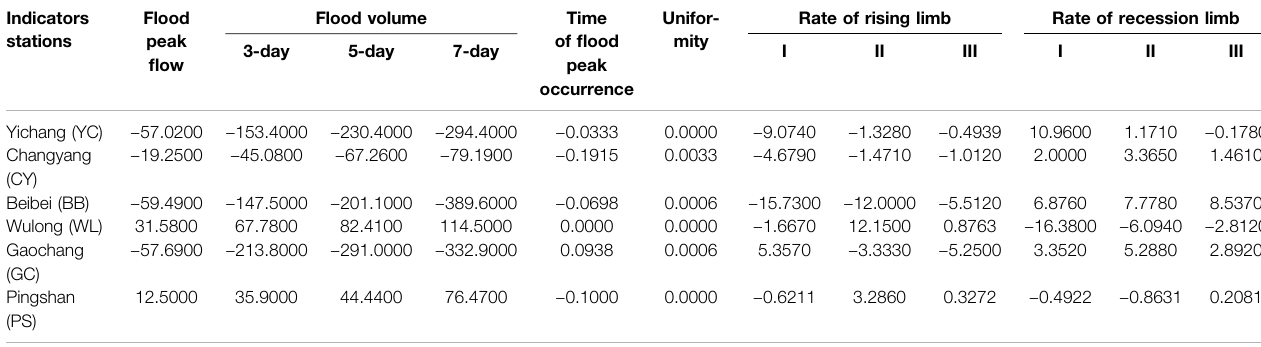
TABLE 4 | The Theil – Sen slope estimator of evaluation indicators at the six stations in the UYR. Indicators stations